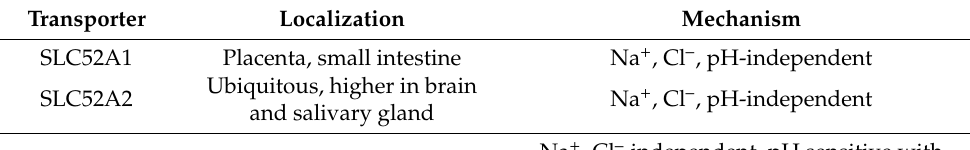
Table 6. Tissue localization of riboflavin transporters in humans.